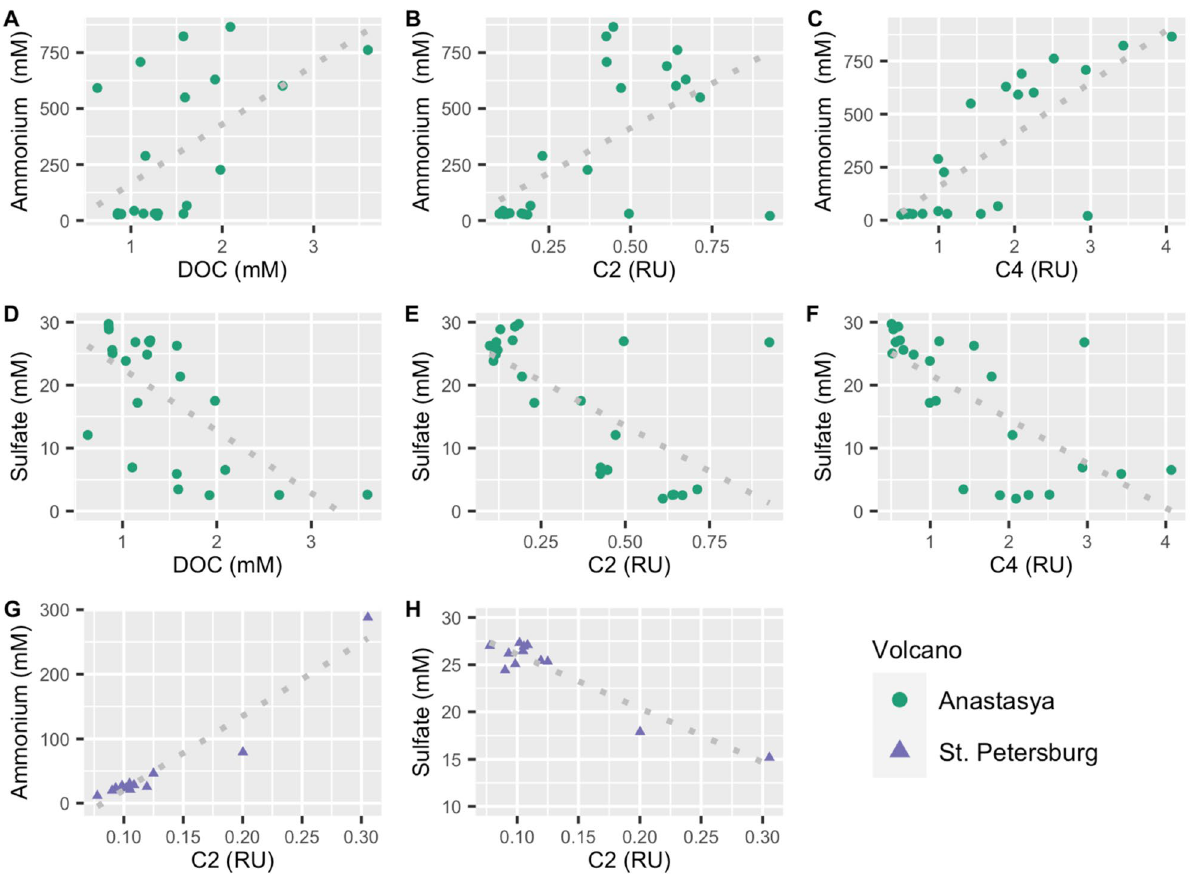
Figure 6. Linear relationship between ammonium and sulfate with dissolved organic carbon (DOC) and fluorescent components C2 and C4 in Anastasya ( A – F ) and St. Petersburg ( G , H ). Only the relationships with p < 0.01 are